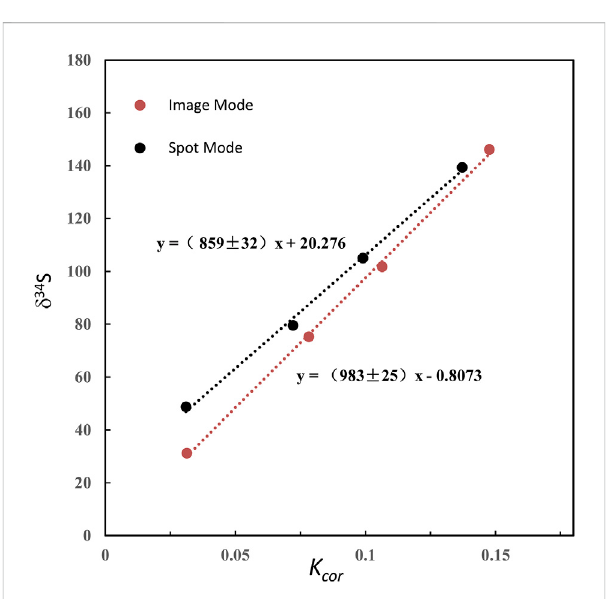
FIGURE 5 The plot of the relation between δ 34 S and Kcor in image mode and spot